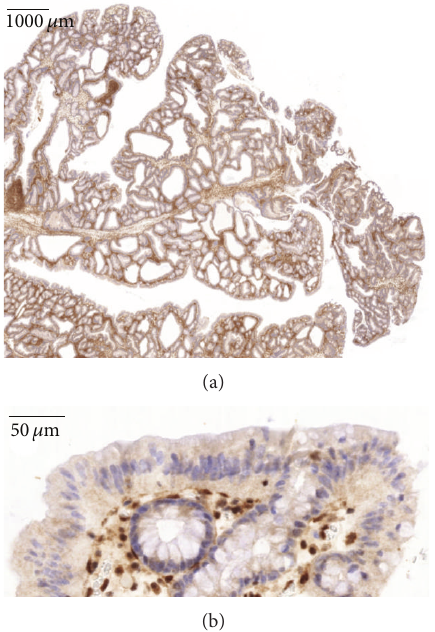
Figure 4: SMAD4 immunohistochemistry. Loss of SMAD4 expres- sion in subset of epithelial cells of the mucosa. (a) Intermingled glands. (b) High power of transition within a